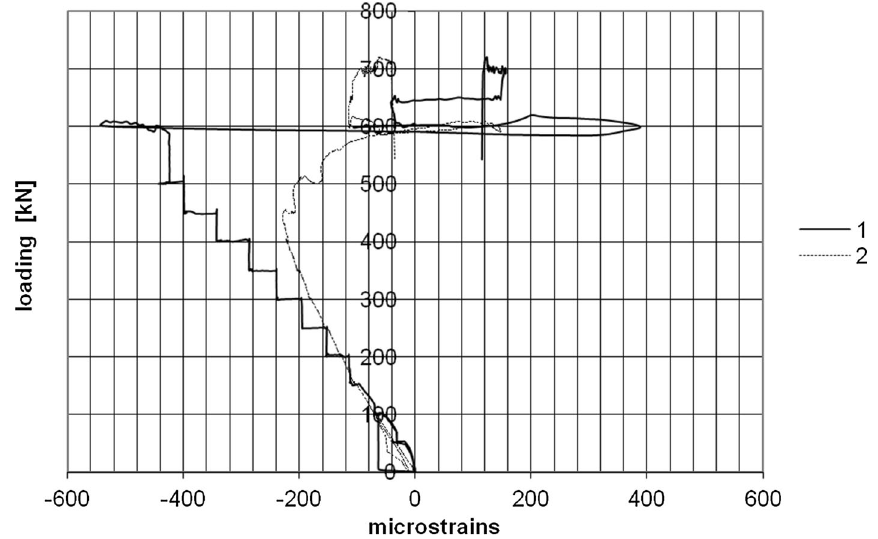
Fig. 20 Registered strains in the concrete of the footing F9 (1, 2, 3-measuring spots—Fig. 8).